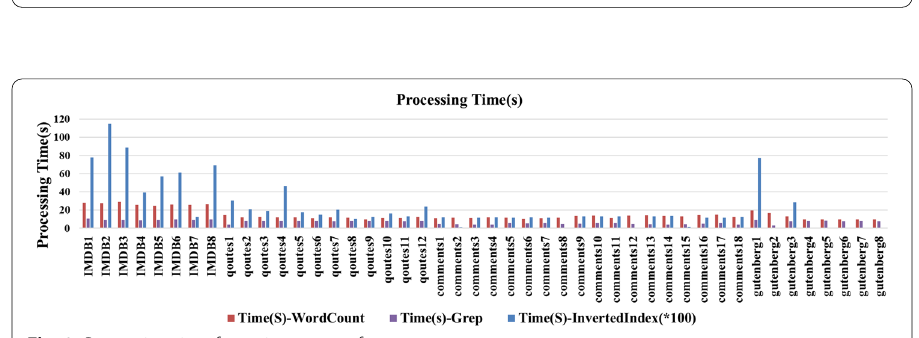
Fig. 1 CPU utilization in various parts of sources